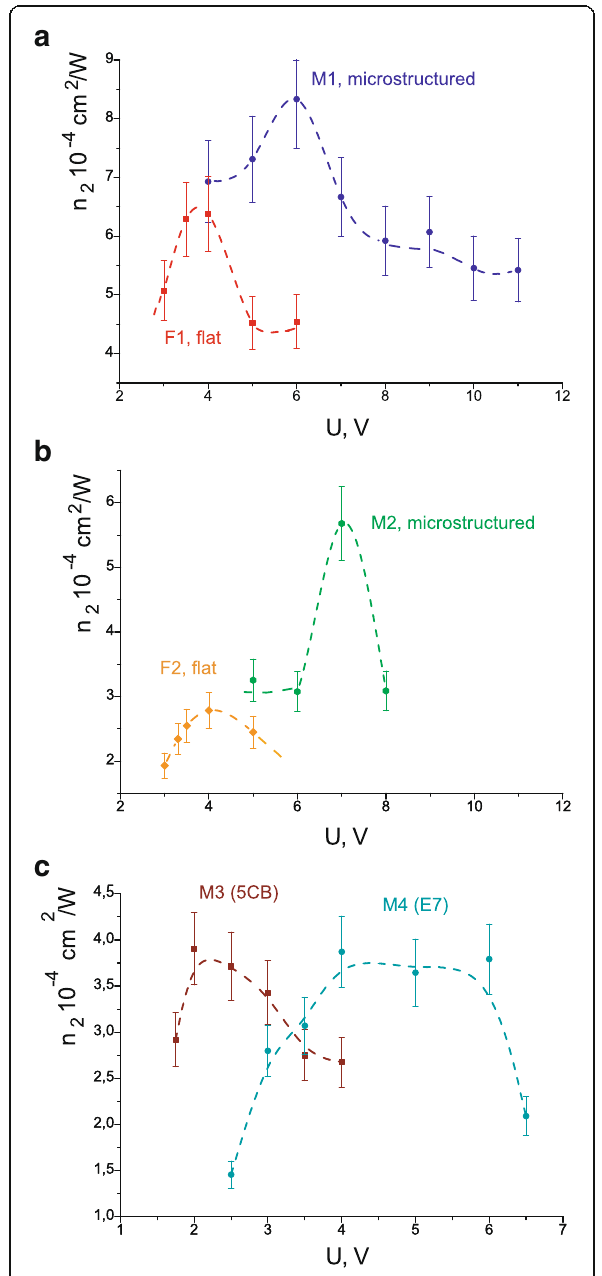
Fig. 7 Calculated coefficients of nonlinear refraction in dependence on applied voltage for cells M1 and F1 ( a ); M2 and F2 ( b ); M3 and M4 ( c ). Dashed lines are for the visualisation only